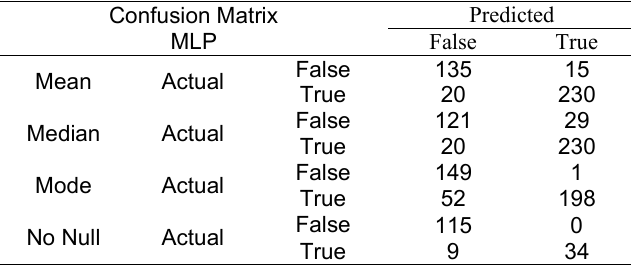
Table 8. Confusion Matrix for Multilayer Perceptron